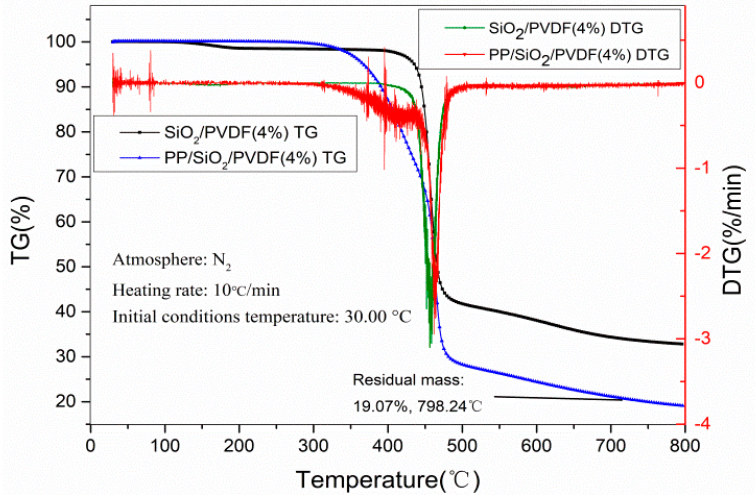
Figure 7. Thermal analysis curve of the PP/SiO 2 /PVDF and SiO 2 /PVDF composite.